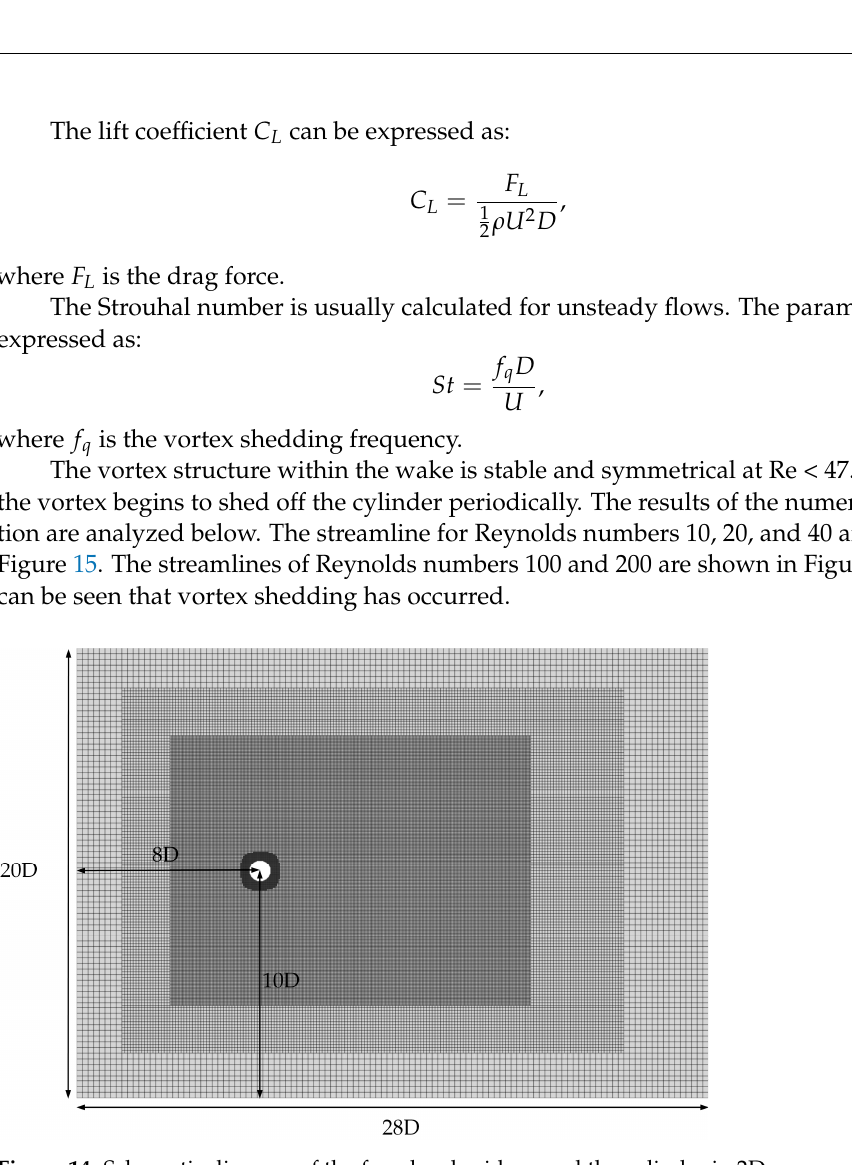
Figure 14. Schematic diagram of the four-level grid around the cylinder in 2D case.